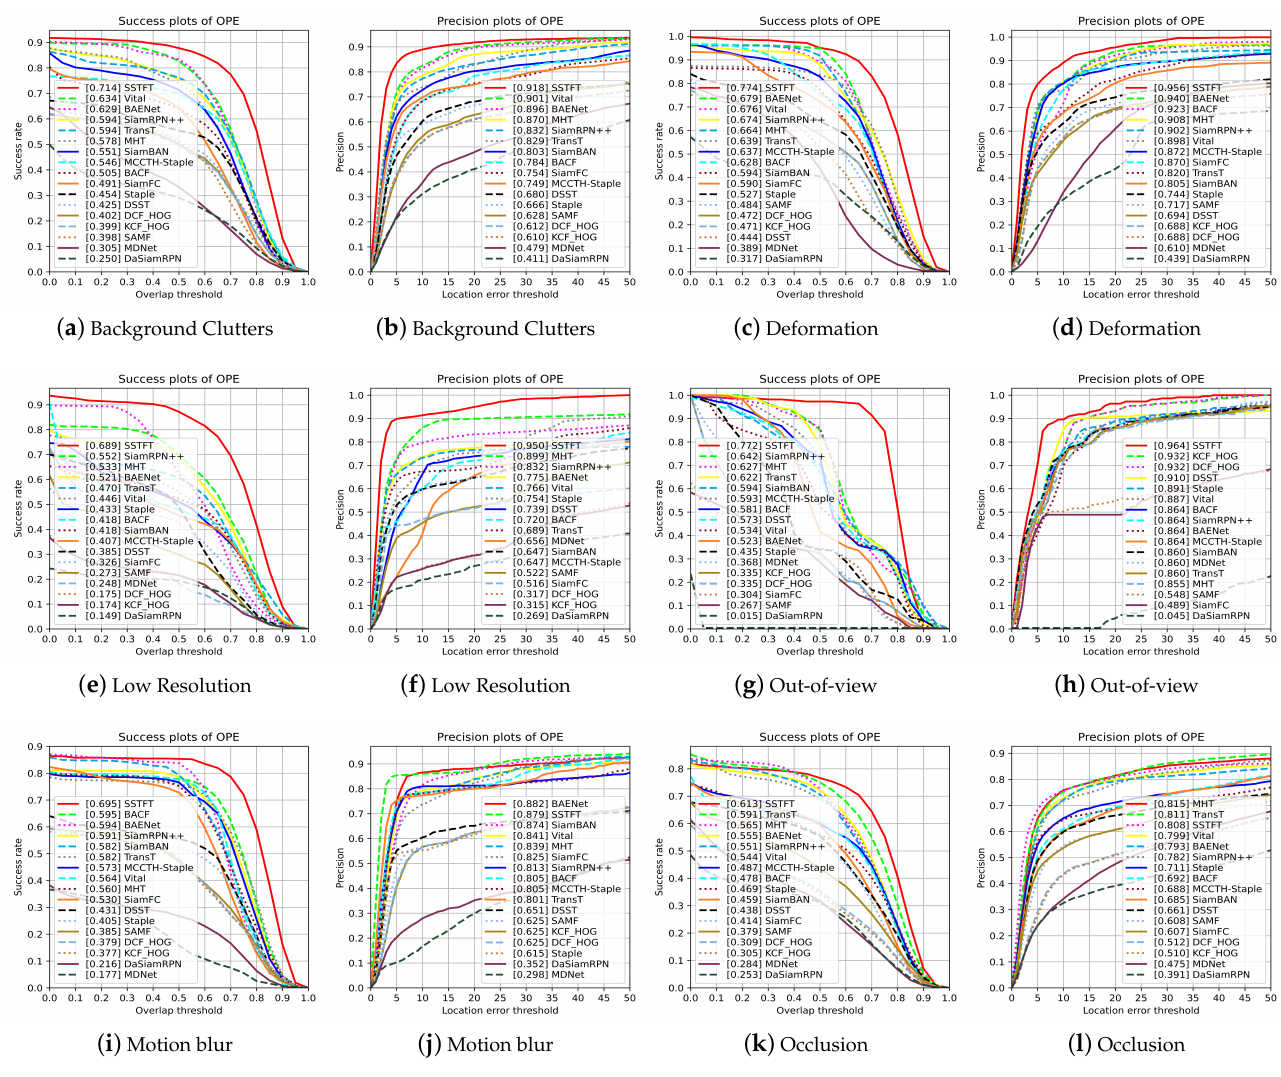
Figure 6. The proposed method compared with all trackers on IMEC16.